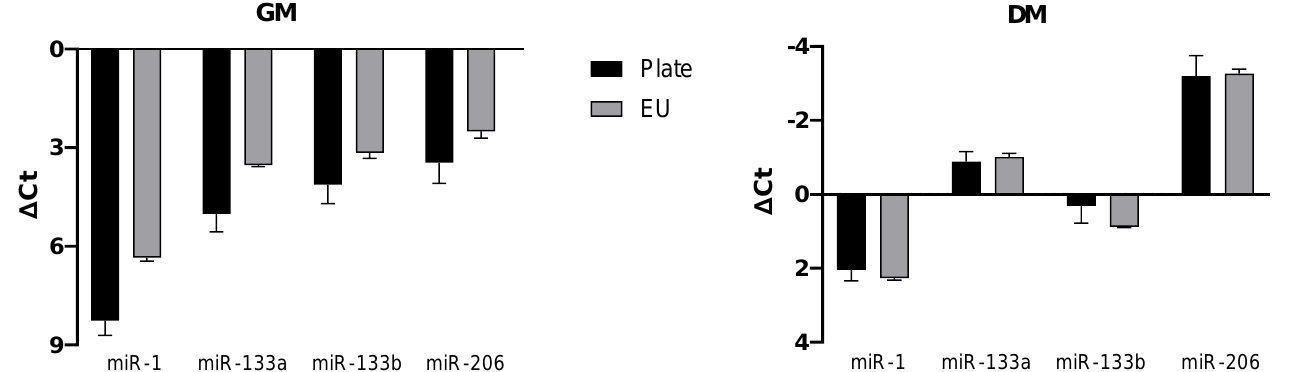
Figure 5. MicroRNA expression profile in huMPCs. The graphs show the relative expression of miR-1,